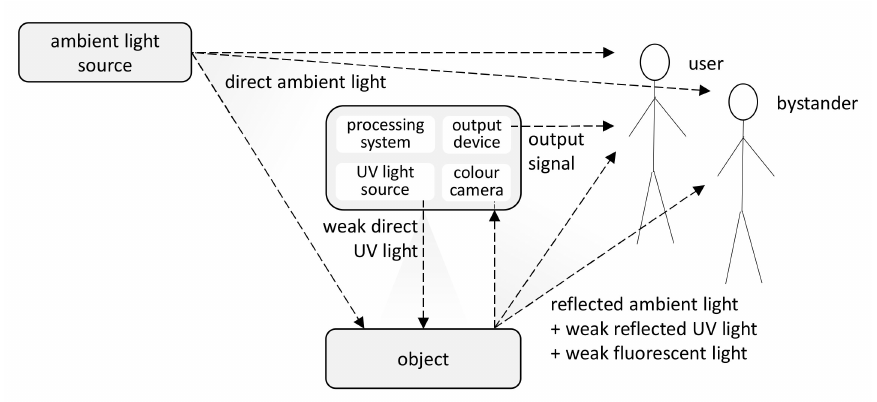
Figure 2. Imperceptible detection of fluorescent markers in ambient light—modulated UV light induces fluorescent light too weak to be seen with the naked eye, which is acquired by a camera and extracted by a processing system to inform the user through an output device (adapted from